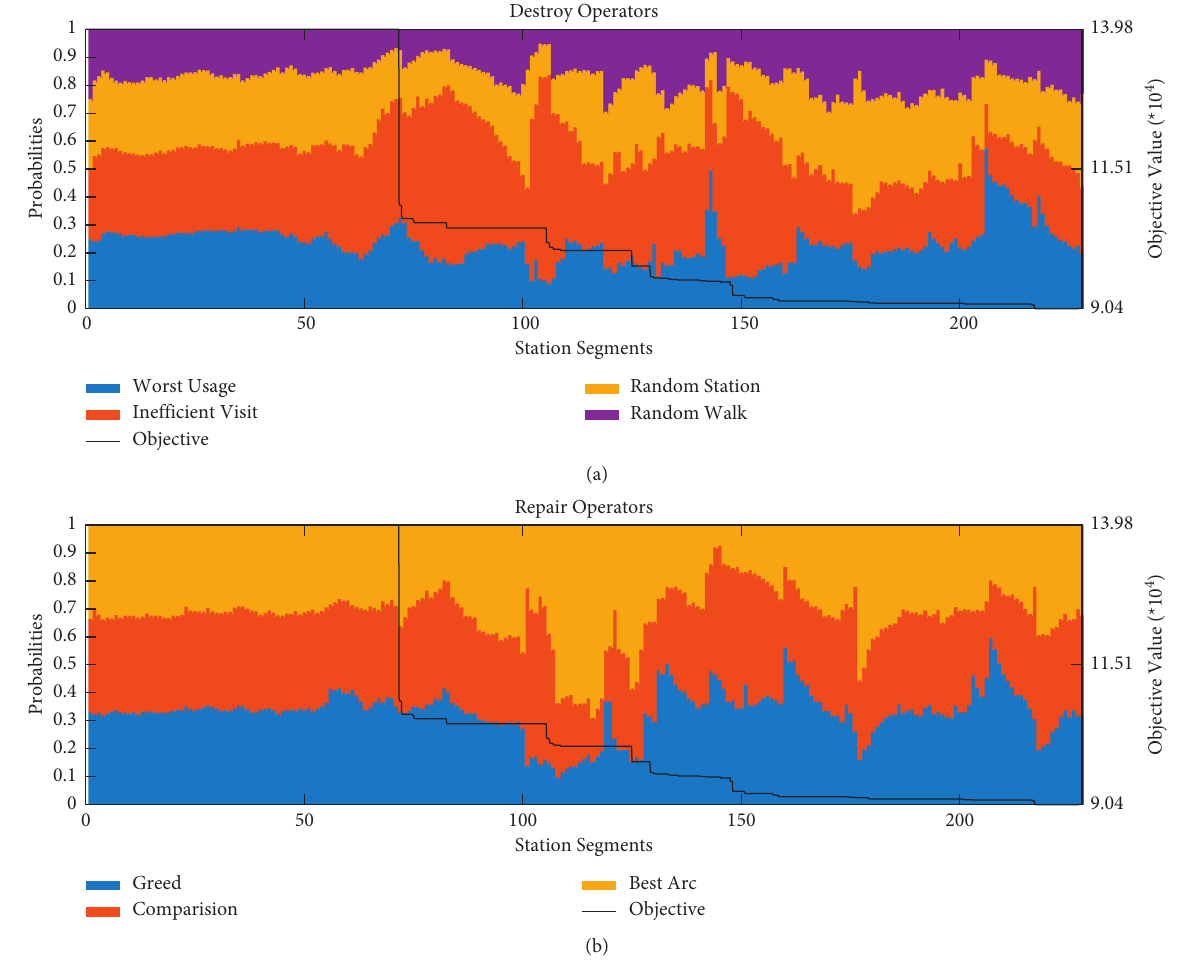
Figure 5: The probabilities of station operators at each segment. (a) Station destroy operators. (b) Station repair